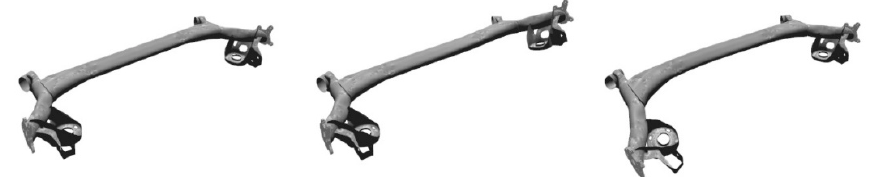
Figure 2. Modal space reduced finite element (FE) model: Screen-shots from an interactive simulation of a car rear-axle.